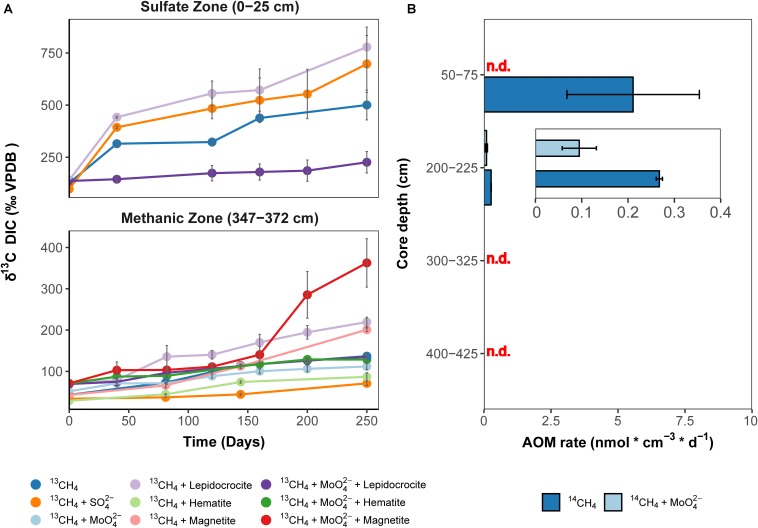
Direct indication for 13CH4 and 14CH4 turnover to CO2 in incubations with Helgoland Mud Area sediments. (A) Change in δ13C-DIC values over 250 days in slurry incubation experiments with sediments from the sulfate zone (0–25 cm) and the methanic zone (347–372 cm) with 13CH4 tracer, n = 3, error bars represent 1 s.d. of biological replicates. The 13C-increase in the DIC pool serves as proxy for AOM. DIC isotope values in control incubations are provided in Supplementary Figure S11. (B) Rates of methane turnover based on 14CH4 in samples from the SMT (50–75 cm), n = 3, and the methanic zone (200–225 cm, 300–325 cm, 400–425 cm), n = 2, error bar represents 1 s.d. of biological replicates. INSET: scale adjusted activity rates in the methanic zone. Using 14CH4, rates of methane turnover were below abiotic control samples in 14CH4 and molybdate treatment from the SMT and in the methanic zone samples from depths 300–325 cm and 400–425 cm after 8 days. “n.d.”: rates not detected above abiotic controls.